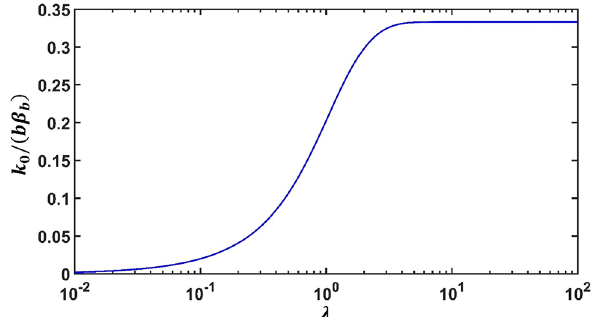
˜ β b β b versus the anisotropy parameter λ . In this illustration, we specify g = 2/3, Figure 3. The value of b = k 0 c = 1/4 and b = 1 μm. Note the curve also applies to the case of g = 3/2, but the vertical axis is now changed to the (cid:31) scale of ˆ α a